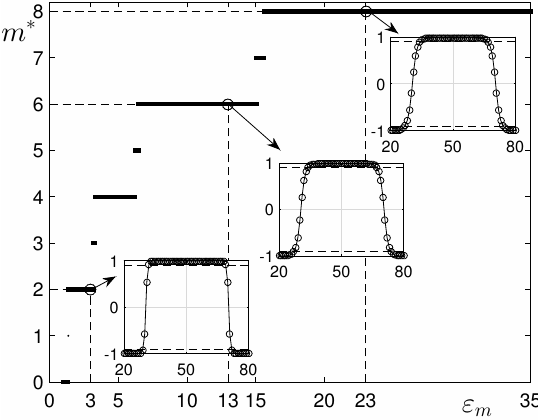
Figure 5. Numerical results at steady state for several values of (cid:101) .